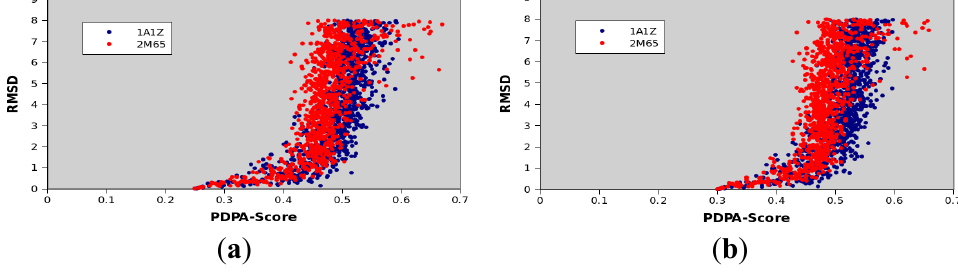
Figure 14. Sensitivity of 2D-PDPA analysis as a function of bb-rmsd on two α -proteins 1A1Z and 2M67 ( a ) with 25% of the data randomly removed and ( b ) with 30% of the data randomly